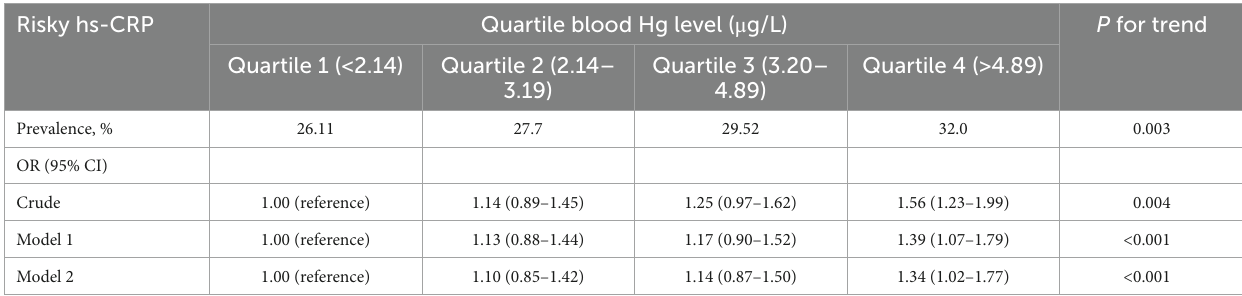
TABLE 3 Prevalences and adjusted odds ratios (95% confidence intervals) of a risky hs-CRP level by quartile of blood Hg in Korean adults aged ≥ 20